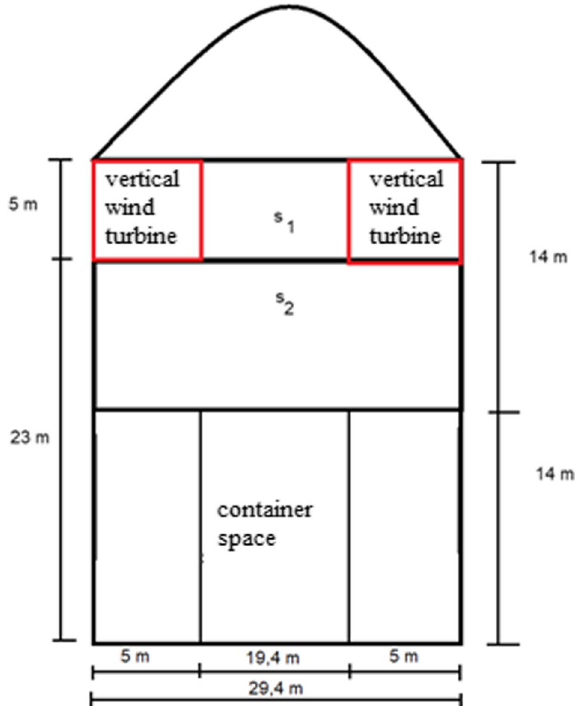
Fig. 14 Positioning scheme of 2 of the 4 large vertical wind turbines installed in the bow of the container